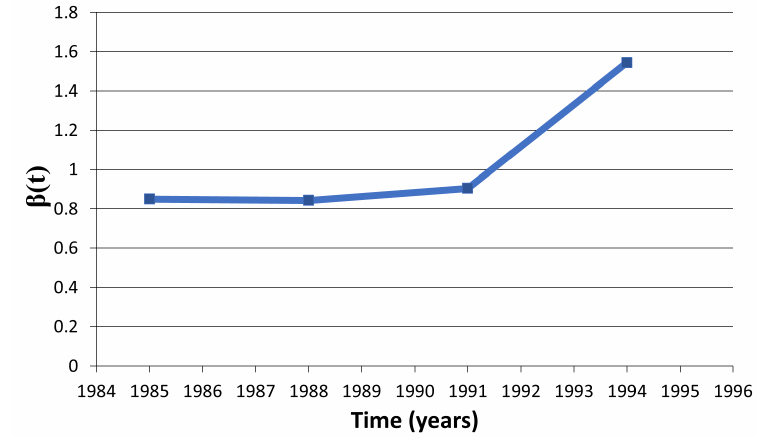
Figure 8. Estimates of β ( t ) related to alcohol drinking college population, when µ =